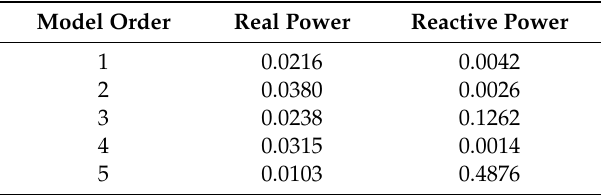
Table 2. Mean absolute error ( MAE) for the modelling of a real / reactive power response of Topology 2, using transfer functions and non-linear equations (TFNL)